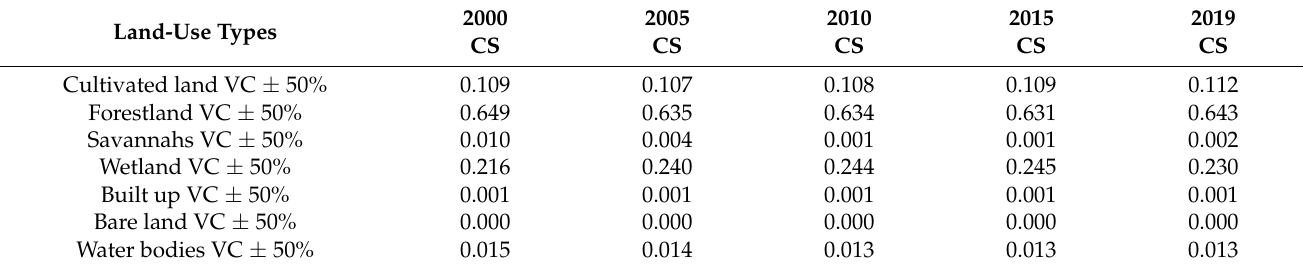
Table 8. Sensitivity coefficient resulting from an adjustment of the equivalent value